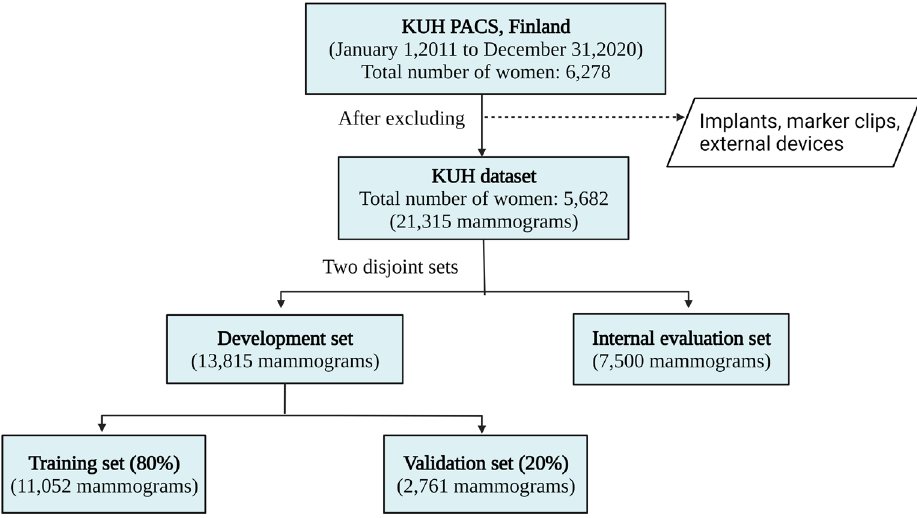
Figure 1. Flowchart describing the KUH dataset preparation. After excluding mammograms containing implants, marker clips, and/or external devices, we divided the KUH dataset into two disjoint sets: the development set and the internal evaluation